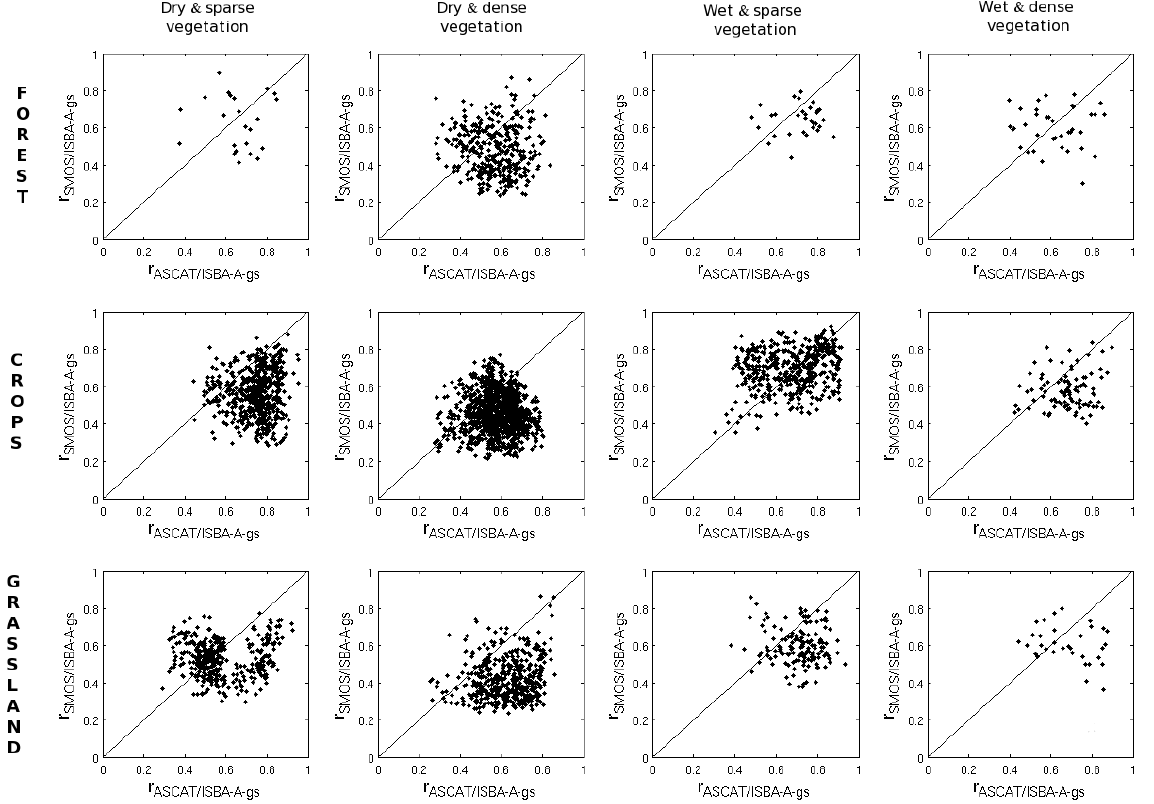
Fig. 6. Impact of vegetation density (dense and sparse) and soil wetness conditions (wet and dry) on SMOS-L2 vs. ASCAT SSM anomaly correlation coefficients with the ISBA-A-gs simulations for crops, forests, and grasslands.